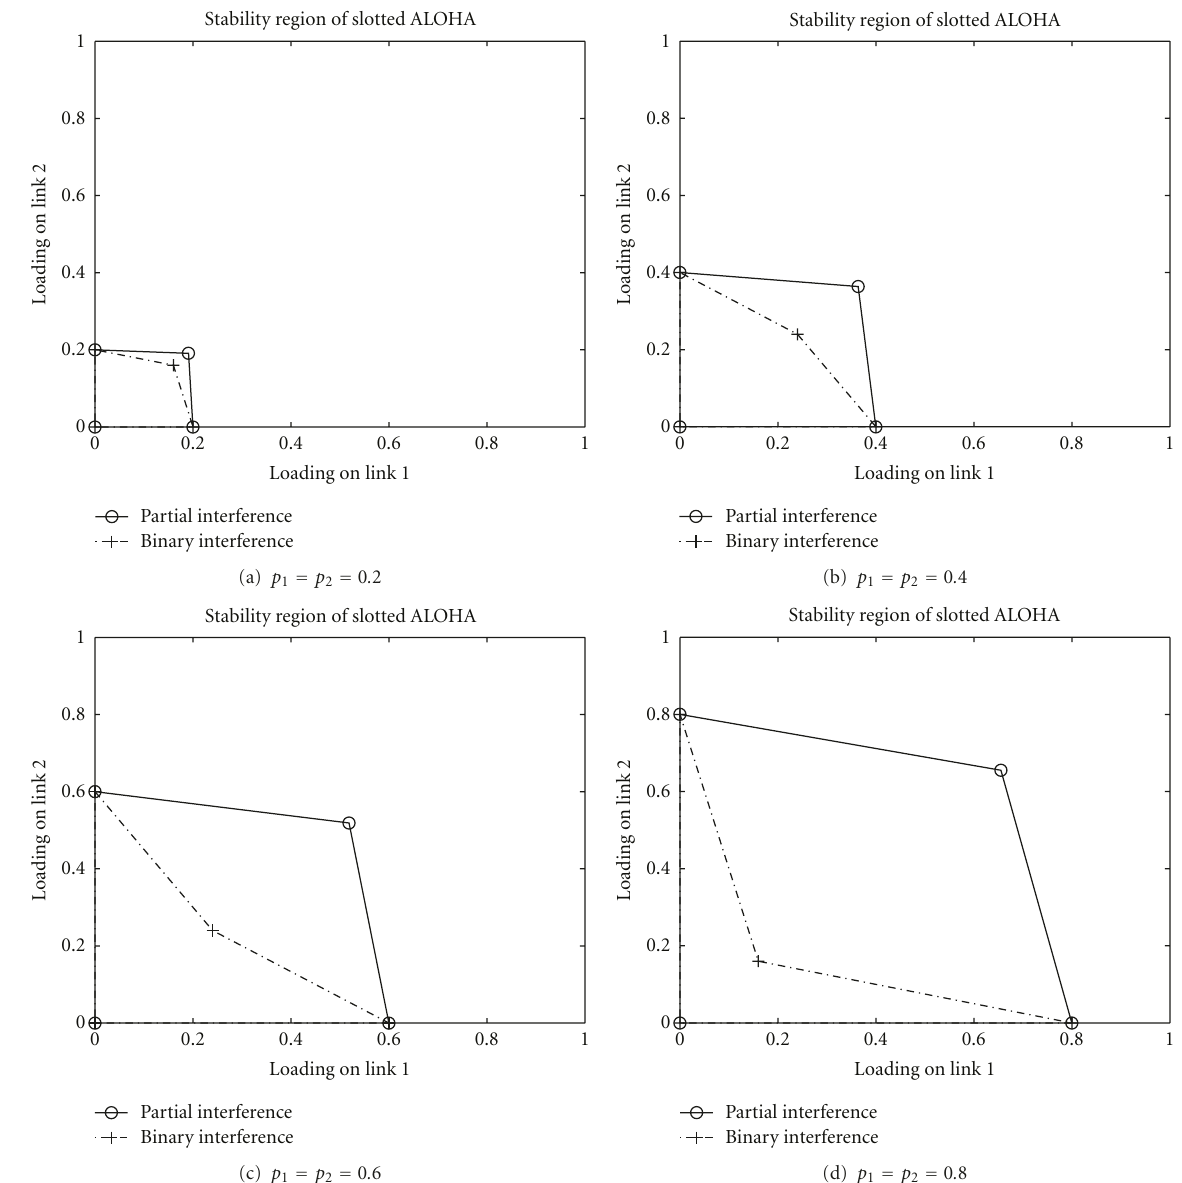
Figure 11: Stability region for M = 2 under binary interference and partial interference with various transmission